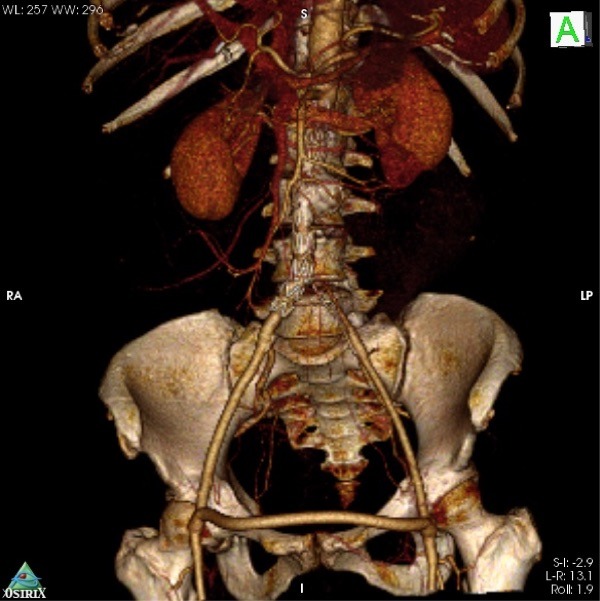
3-D reconstruction produced with Osirix® software, showing monoiliac endoprosthesis and femorofemoral crossover graft, patent and with no evidence of pseudoaneurysms.